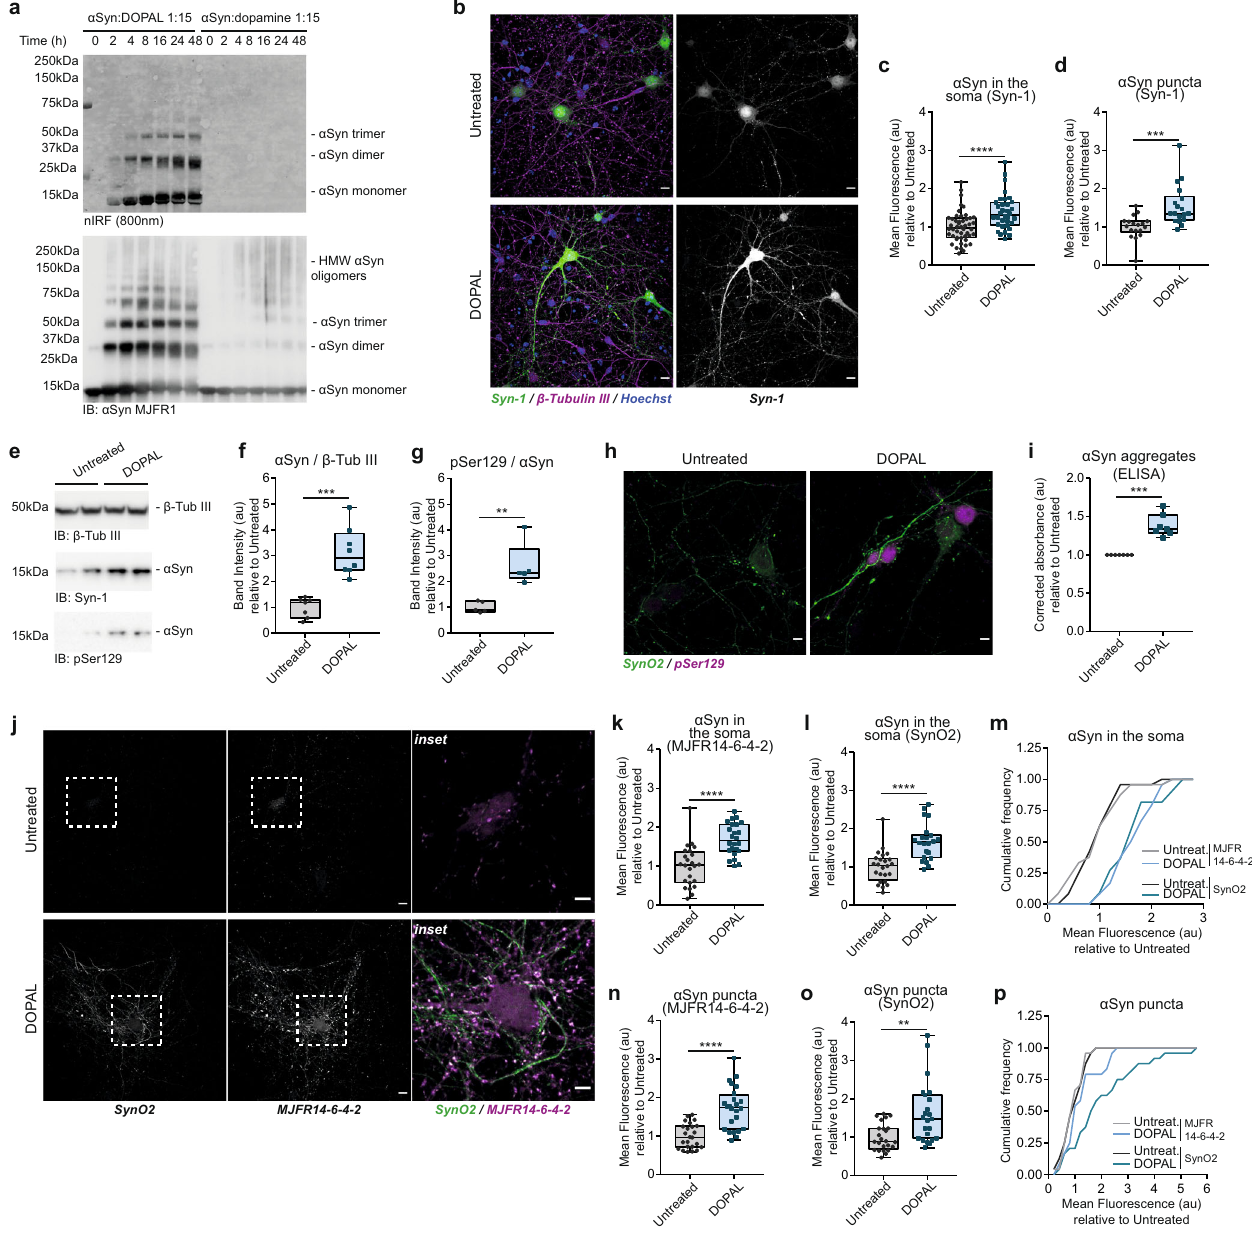
Fig. 1 DOPAL affects α Synuclein proteostasis in primary mouse neurons. a In vitro aggregation assay of recombinant α Syn incubated with 1:15 DOPAL or dopamine at different time-points, resolved by SDS-Page. The signal derived from oxidized DOPAL covalently bound to α Syn is acquired by nIRF at 800 nm (top panel), whereas total α Syn oligomers are detected by immunoblot (bottom panel). b – p Imaging and biochemical studies of DOPAL-induced α Syn buildup in untreated and 100 μ M DOPAL-treated (for 24 h) wild-type primary mouse cortical neurons. b Immunostaining of α Syn (Syn-1, green) and β -Tubulin III (magenta). Nuclei are stained with Hoechst (blue). Scale bar: 10 μ m. DOPAL-induced α Syn accumulation is expressed as mean fl uorescence intensity c in neuronal soma and d α Syn-positive puncta. e – g Monomeric α Syn and pSer129 levels analyzed by western blot. Band intensities are normalized to β -Tubulin III as loading control. Data from three independent cultures are normalized to each untreated sample, pooled together, and analyzed by Mann – Whitney test (** p < 0.01, *** p < 0.001, **** p < 0.0001). h Co-immunostaining of aggregated (SynO2) and phosphorylated (pSer129) in the same experimental conditions. Scale bar: 10 μ m. i Quanti fi cation of aggregated α Syn in neuron cell lysates by ELISA expressed as fold change in DOPAL-treated neurons relative to untreated paired samples. Data from seven biological replicates are analyzed by One-sample t-test (*** p < 0.001). j Co- immunostaining of anti-aggregated α Syn antibodies SynO2 and MJFR14-6-4-2. Scale bar: 10 μ m, 5 μ m in the inset. α Syn buildup is expressed as mean fl uorescence intensity k , l in neuronal soma and n , o α Syn-positive puncta. Data from two independent cultures are normalized to each untreated sample, pooled together, and analyzed by Mann – Whitney test (** p < 0.01, *** p < 0.001, **** p < 0.0001). In the same images, cumulative frequency distribution of fl uorescence intensities derived from the immunostaining with SynO2 and MJFR14-6-4-2 antibodies measured m in the soma and p in the synaptic puncta. Data are analyzed by Two-way ANOVA with Tukey ’ s multiple comparison test: m untreated MJFR14-6-4-2/SynO2 vs DOPAL MJFR14-6-4-2/SynO2: **** p < 0.0001; p untreated MJFR14-6-4-2 vs DOPAL MJFR14-6-4-2: ns, untreated SynO2 vs DOPAL SynO2: **** p < 0.0001, DOPAL MJFR14-6-4-2 vs DOPAL SynO2: **** p < 0.0001. c , d , f , g , I , k , l , n , o Data are displayed as box and whiskers plot showing the minimum and maximum points (whiskers), the fi rst quartile, median and third quartile (box